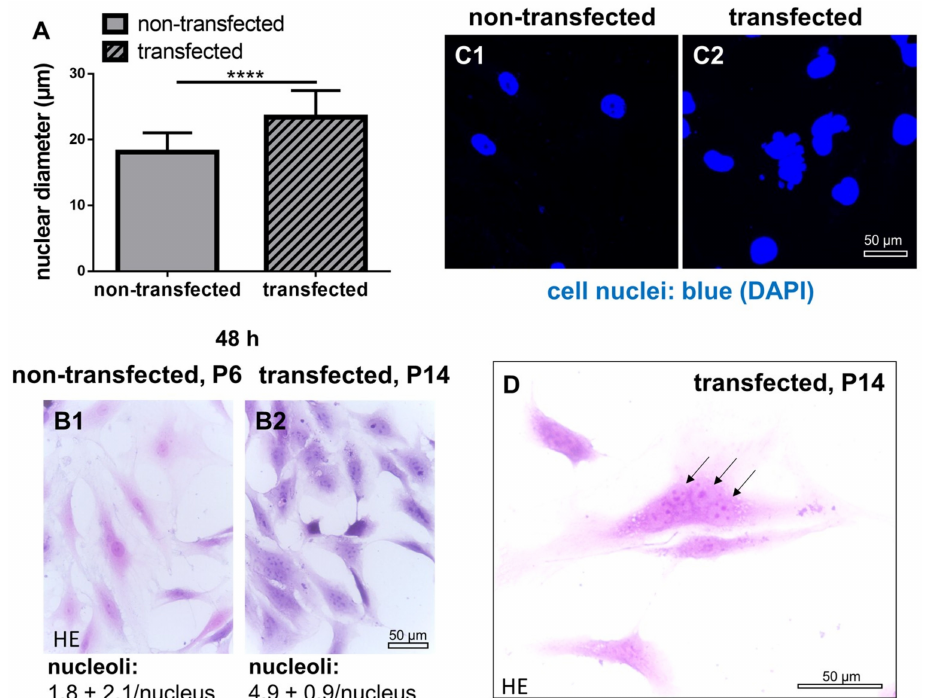
Figure 4. Size and shape of cell nuclei, numbers of nucleoli of non-transfected and SV40 transfected ACL ligamentocytes in 2D culture. ( A ) Nuclear diameter. ( B1 , B2 ) Number of nucleoli in non-transfected (B1) and transfected (B2) ACL ligamentocytes stained using hematoxylin eosin (HE). Nuclear morphology in non-transfected ( C1 ) and transfected cells ( C2 ). Cell nuclei of ACL ligamentocytes were visualized using 4 (cid:48) ,6 (cid:48) -diamidino-2-phenylindol (DAPI, blue). ( D ) Random cell division without cytokinesis was shown by HE staining. Arrows: Multiple cell nuclei within one singular cell. Scale bars: 50 µ m. **** p < 0.0001.